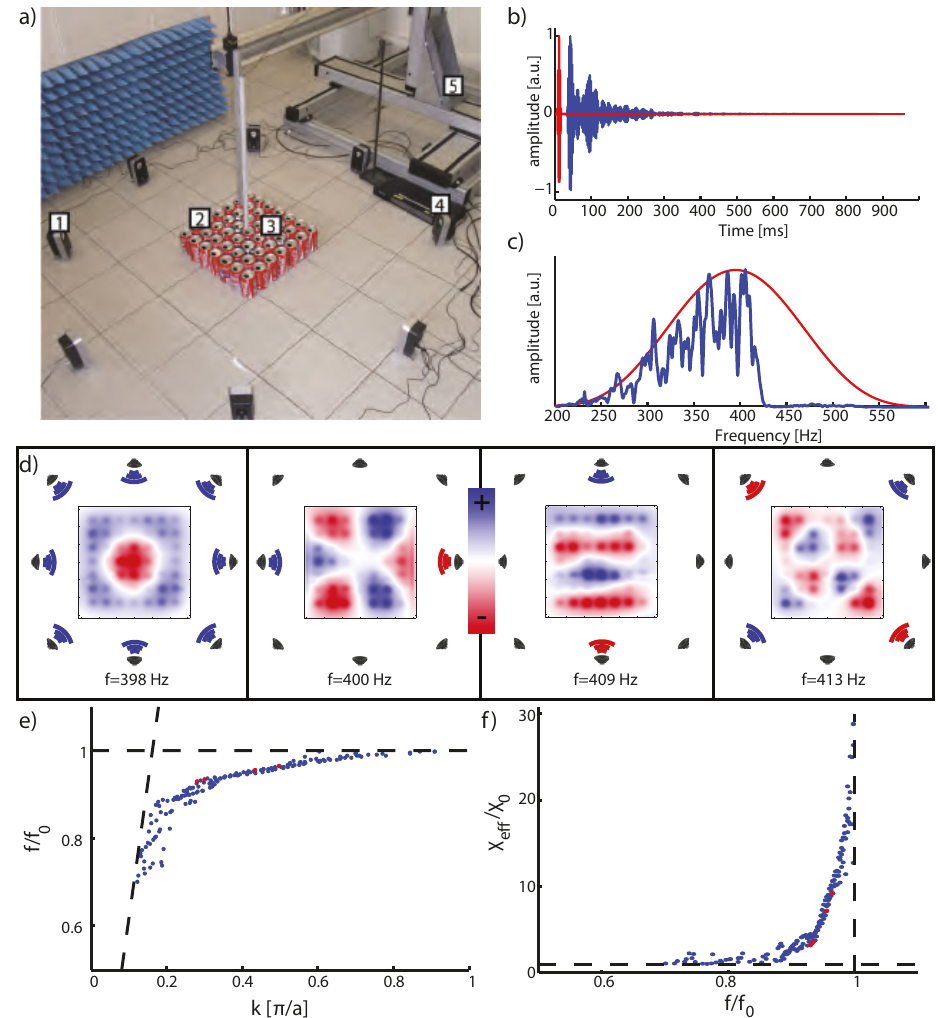
( a ) Experimental setup: 8 commercial computer speakers (1) are controlled using a multi-channel soundcard (4) and create sounds exciting the soda cans metamaterial (2). Mounted on a 3D moving stage (5), a microphone records the pressure field; ( b ) Typical emitted pulse ( red ) and the measured signal ( blue ) on top of one can and their spectra ( c ); ( d ) Measured monochromatic patterns at distinct frequencies and with different emitting patterns; ( e ) Experimental dispersion relation and its equivalent in terms of effective compressibility ( f